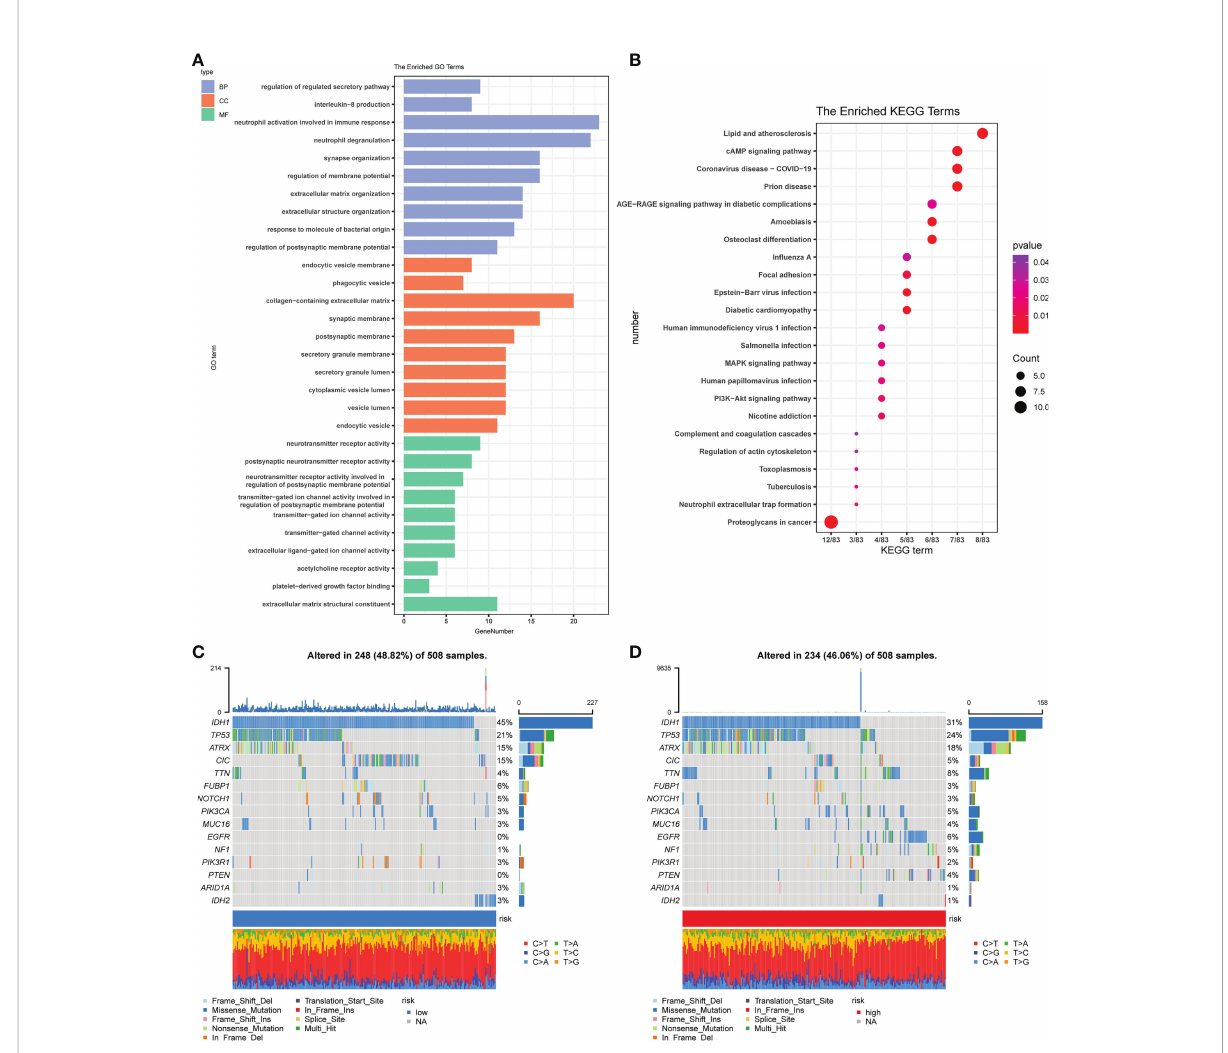
FIGURE 5 Functional and mutational analyses based on the risk model. (A) The enriched item in gene ontology analysis. Blue represents BP (biological process), orange represents CC (cellular component), and the green represents MF (molecular function). (B) The enriched item in Kyoto Encyclopedia of Genes and Genomes analysis. The color indicates the size of the P-value, and the size of the circle indicates the number of genes. (C) Mutation pro fi le in the low-risk group. (D) Mutation pro fi le in the low-risk group. The small fi gure above shows the TMB, whereas the number on the left shows the mutation frequency of each gene, and the fi gure on the right shows the proportion of each